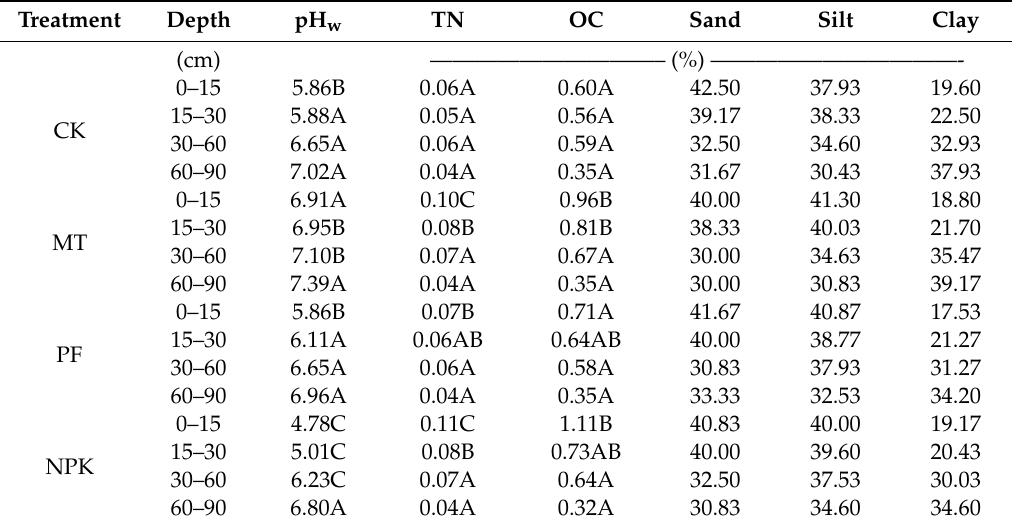
Table 1. Basic properties of soils sampled in 2018 by treatment and depth.